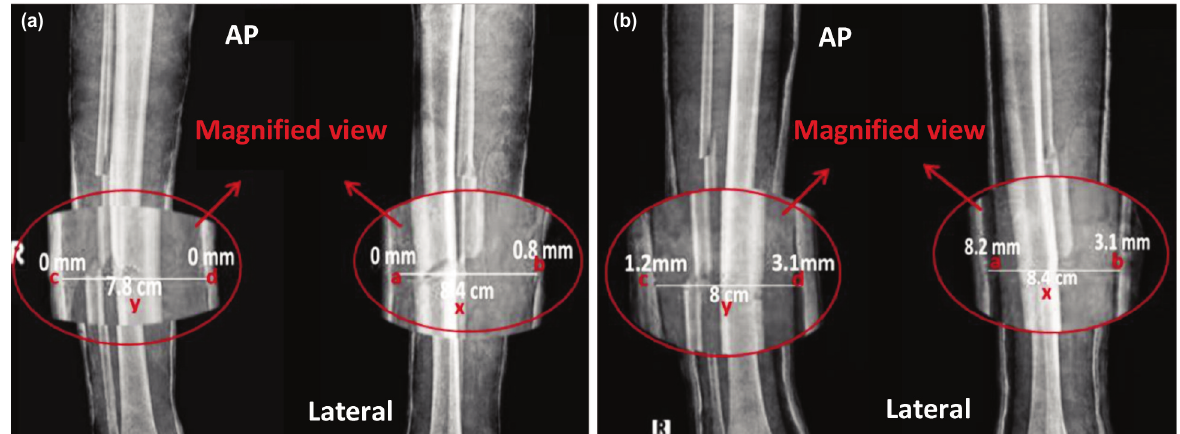
Radiographs of fracture site (a) Immediate post-reduction and (b) At 3 weeks Fig. 2: